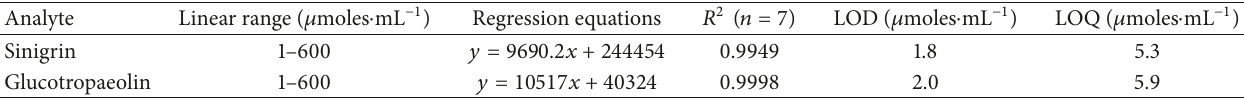
Table 2: Linear range, correlation coefficient ( 𝑅 2 ), limit of detection (LOD), and limit of quantification (LOQ) of HPLC system used for glucosinolates determination.